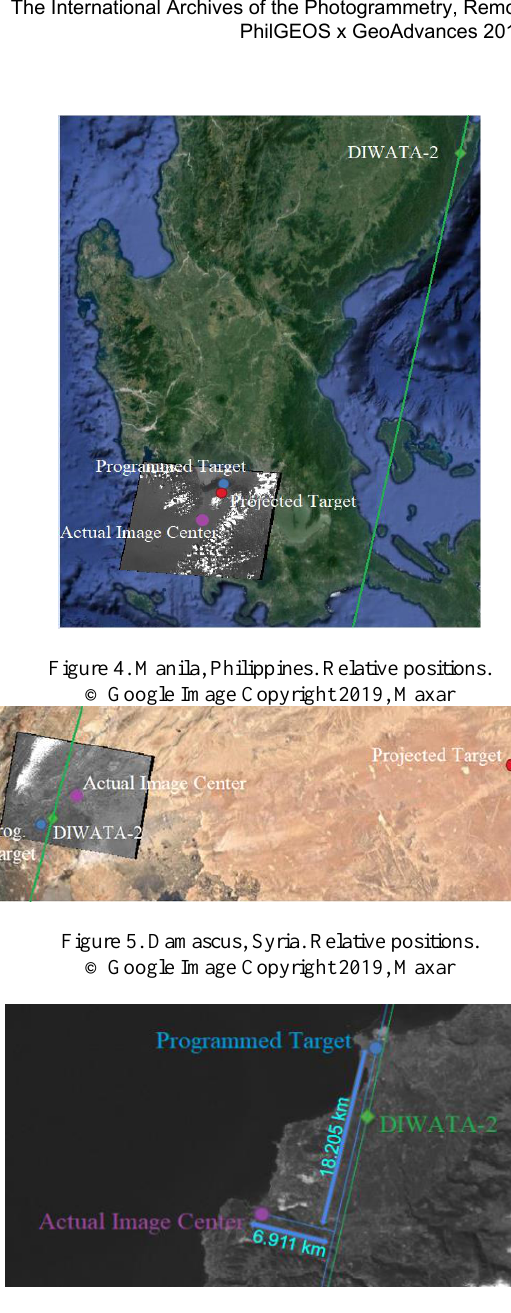
Figure 6. Tripoli, Lebanon. Distance from programmed target to actual image center.